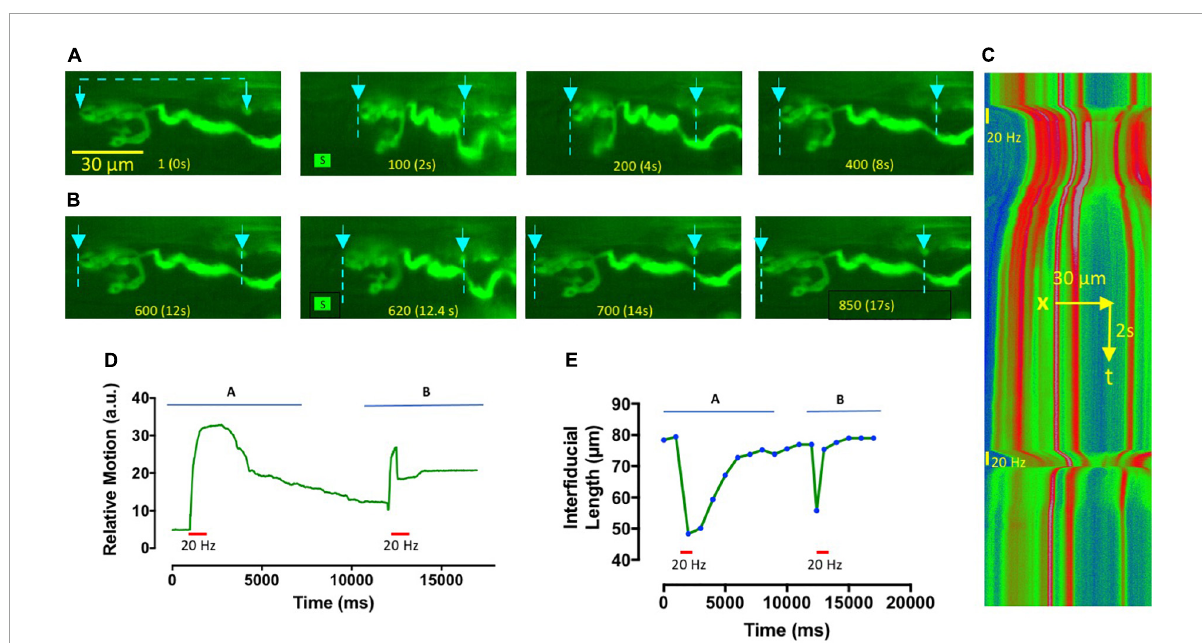
FIGURE2 Omethoate-induced contractures and aftercontractions are localized to NMJs. (A,B) Image frames from Supplementary Video 1 , showing an NMJ in TS muscle from a thy1.2YFP16 mouse, after approximately 1 h incubation in omethoate (100 µ M). Muscle Na V 1.4 channels were also blocked by pre-incubation in µ CTX-GIIIB. Two 20 Hz, 1 s stimulus trains (S)were delivered to this NMJ about 30 s apart. Frame numbers and corresponding times are indicated at the bottom of each frame. The first stimulus train (A) produced a powerful contracture and prolonged aftercontraction of the endplate, while the second tetanic stimulus (B) caused a rapidly adapting focal NMJ contraction for the duration of the stimulus train only (Compare with Figure 1C ). Arrows and dotted lines show the locations of fluorescent points used as fiducial marks for analysis of endplate shortening and its kymographic display. (C) Kymograph of a line scan between the markers indicated on the video frames shown in panels (A,B) , pseudocoloured (Rainbow LUT in FiJI) in proportion to fluorescence intensity between the fiducial points indicated. The timings and duration of tetanic stimulation at 20 Hz are indicated by vertical bars. Note the prolonged shortening of the endplate region following the first tetanic response and the shorter period of endplate contracture in response to the second tetanic stimulus train. (D) Relative motion of the images obtained by analysis of the lowermost bouton using the Muscle Motion plugin for FiJI (arbitrary units of image intensity), further demonstrating that prolonged aftercontraction occurred in response to the first tetanus but the second produced a weaker, rapidly adapting tetanic response. (E) Plot of inter-fiducial length, indicative of endplate shortening. Symbols show measurements that were made on selected video frames at the time points indicated. Horizontal bars in panels (D,E) indicate the period of tetanic